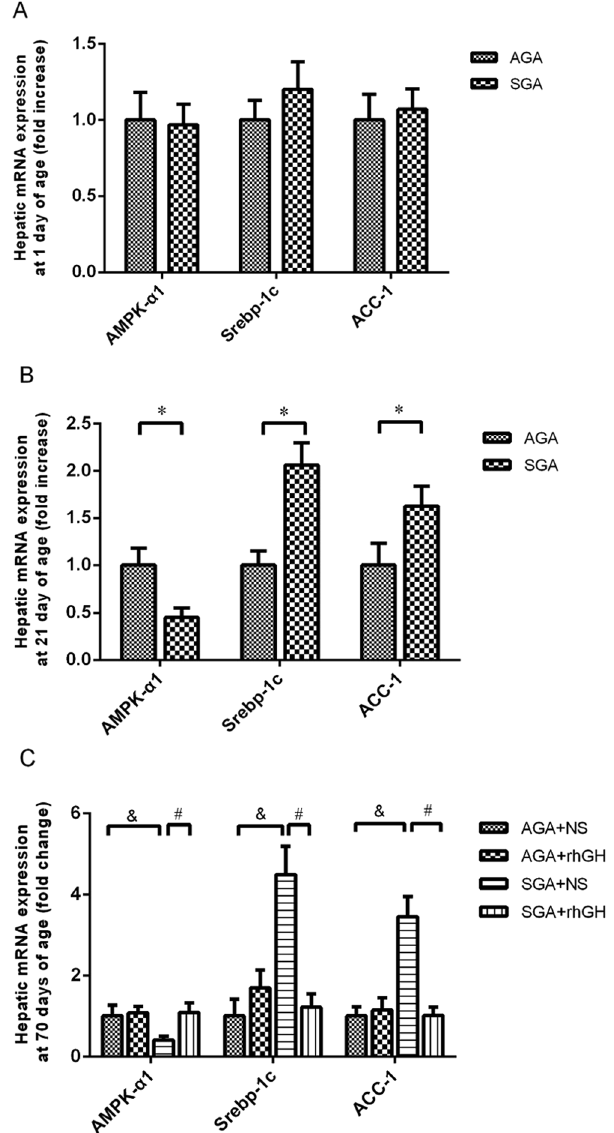
Figure 4. Real-time RT-PCR analysis of hepatic AMPK- α 1, nSREBP-1c and ACC-1 mRNA expression. Results are expressed as fold change compared to the AGA or AGA + NS of same age. Hepatic mRNA expression at neonatal ( A ) adolescent ( B ) and adult ( C ) periods. Statistical differences between the groups are given as follows: * p < 0.05: AGA vs SGA; & p < 0.05: AGA + NS vs SGA + NS; # p < 0.05: SGA + NS vs SGA + rhGH. n = 8 per experimental